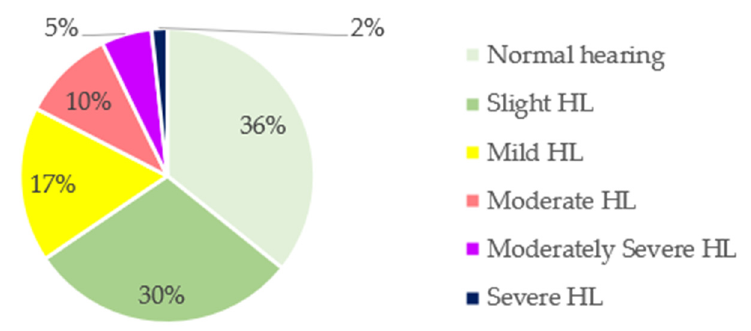
Figure 1. Classification of hearing loss (HL) in the total sample according to the American Speech– Language–Hearing Association (ASHA).